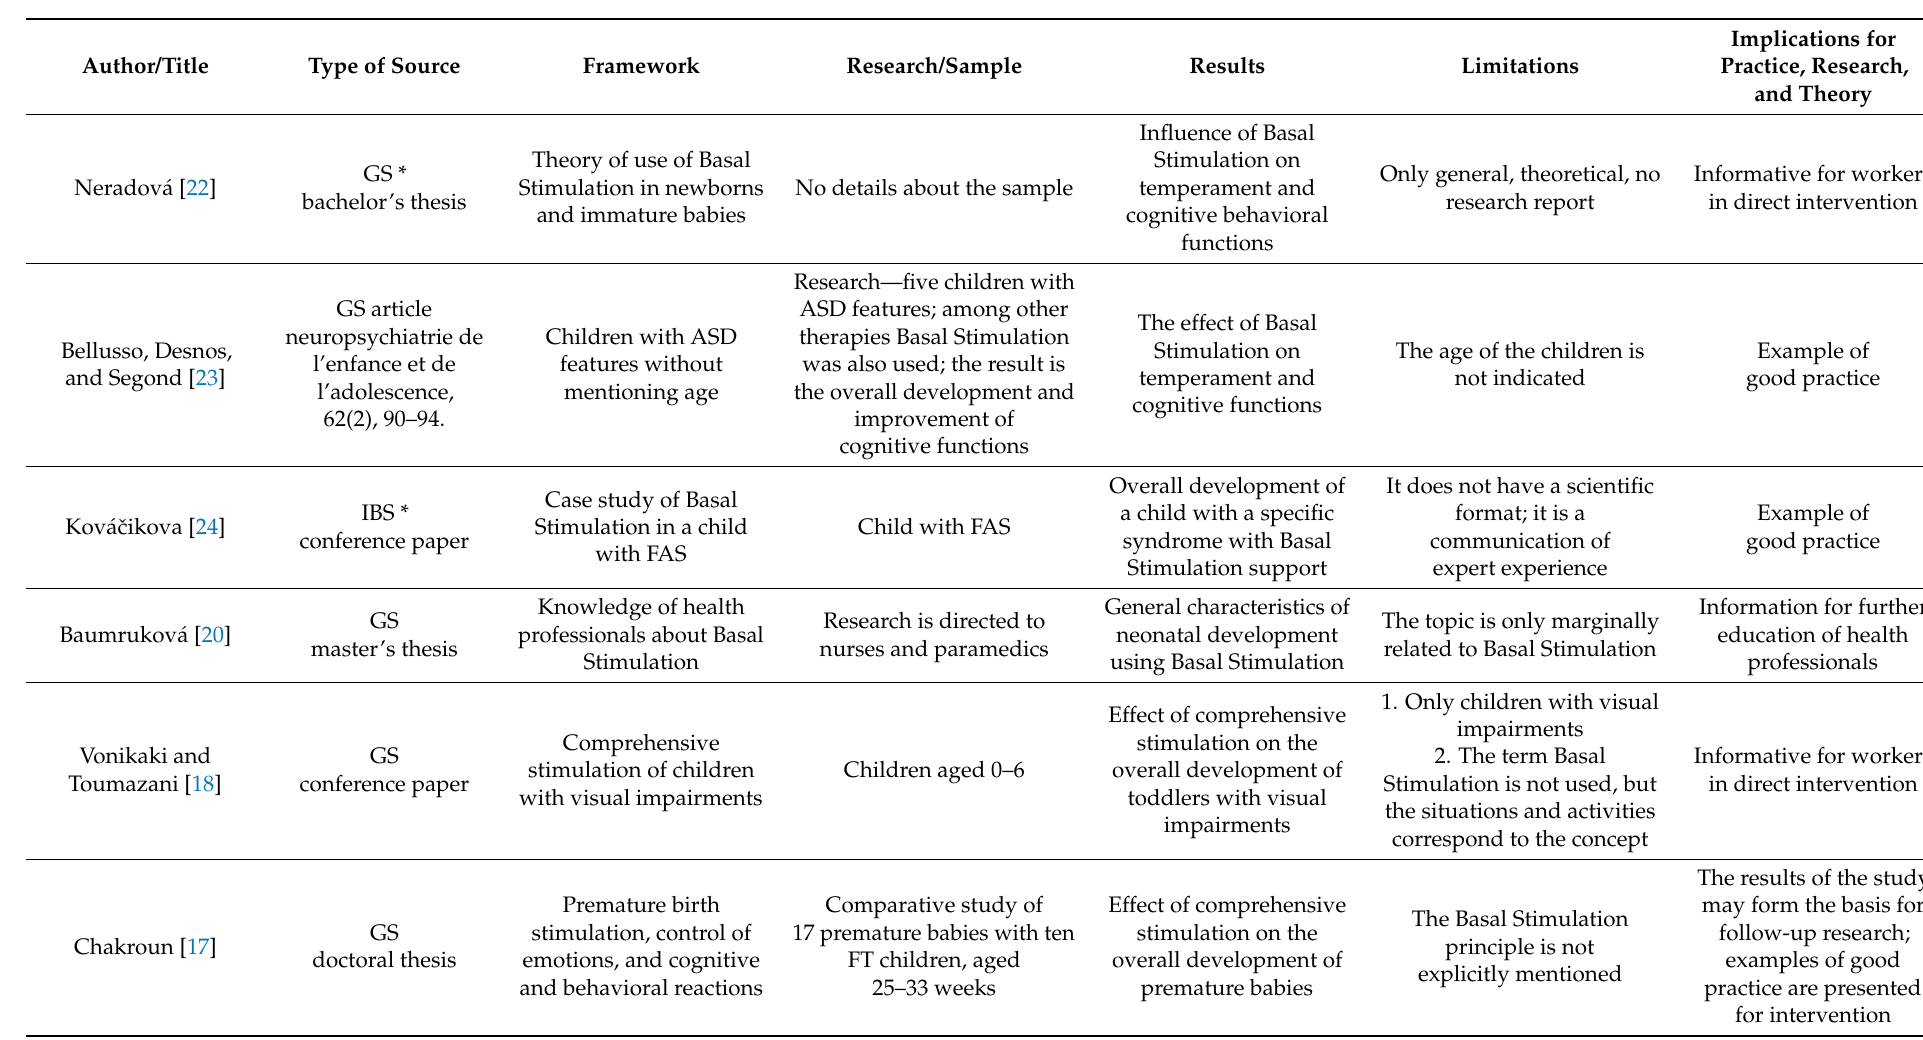
Table 2. Basic information about the sources found from Google search and Institute of Basal